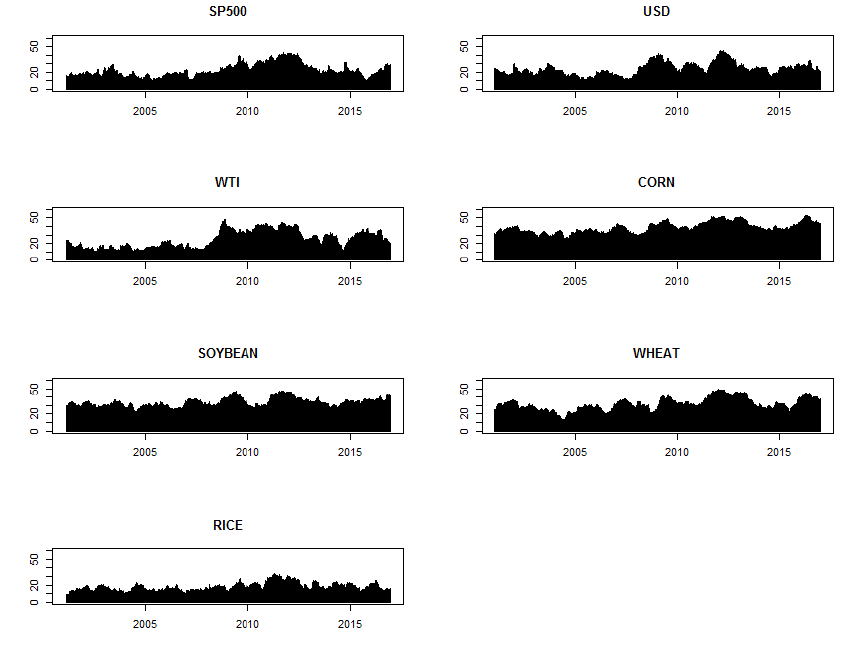
Figure 3A: Directional volatility spillovers, FROM seven markets (the OLS method)